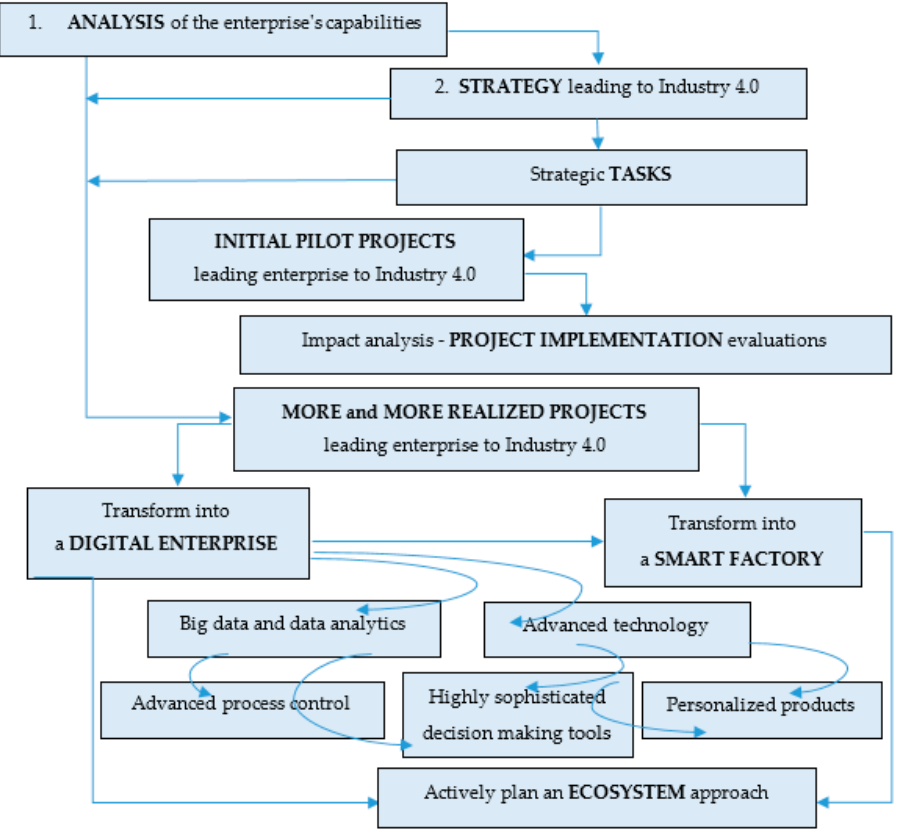
Figure 3. The way to Industry 4.0—key steps. Source: own study.